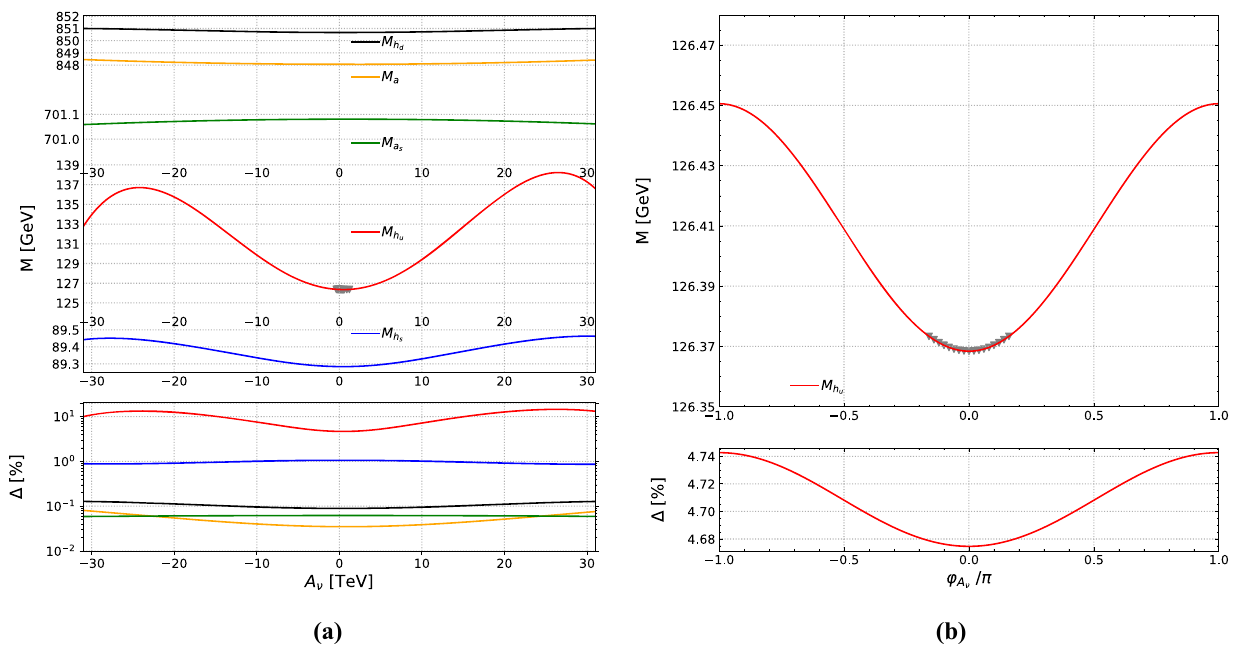
Fig. 5 The same as Fig. 4 but now we show the dependence on: a the neutrino trilinear coupling parameter A ν and b the complex phase of A ν . The gray triangles denote the points satisfying our constraints